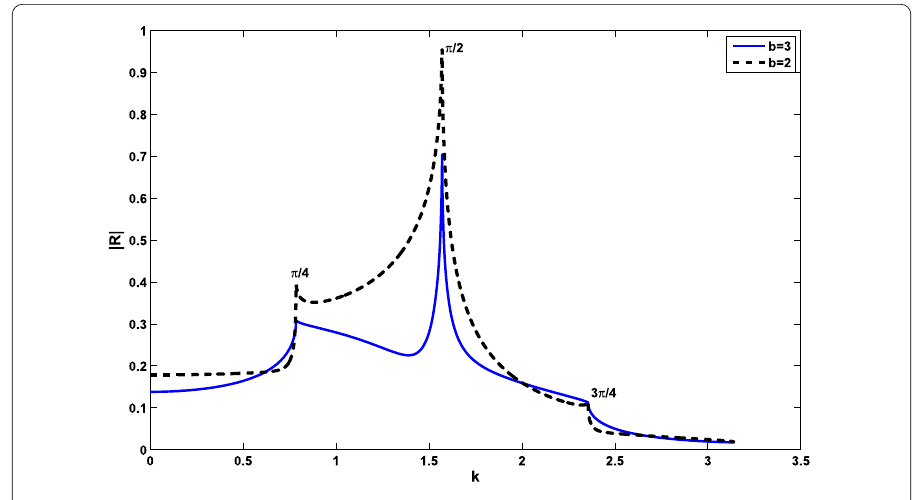
Figure 5 Reflected field amplitude | R | versus the wave number k for a = 1 and d = 4.